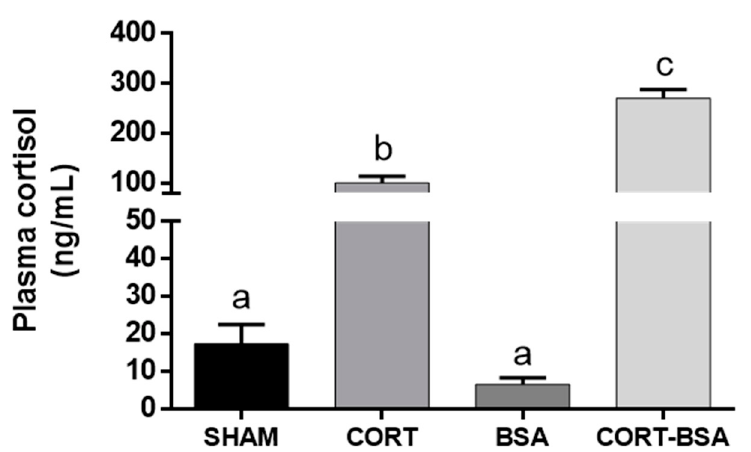
Figure 1. Plasma cortisol levels in vehicle (sham-control), cortisol, BSA and cortisol-BSA administered fish at 72 h post-treatment. Results are expressed as mean ± SEM ( n = 8). Different letters indicate significant differences between groups ( p value < 0.05). All data were analyzed using one-way ANOVA and Tukey’s HSD as a post-hoc test.